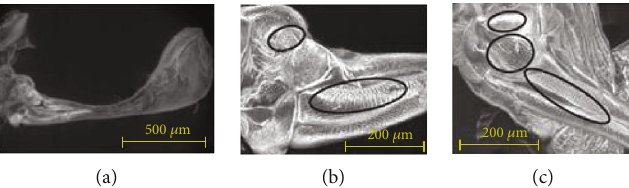
Figure 3: SEM images of the (a) soldier fl y ’ s haltere and sensilla pattern at the (b) ventral and (c) dorsal surfaces of the haltere base.